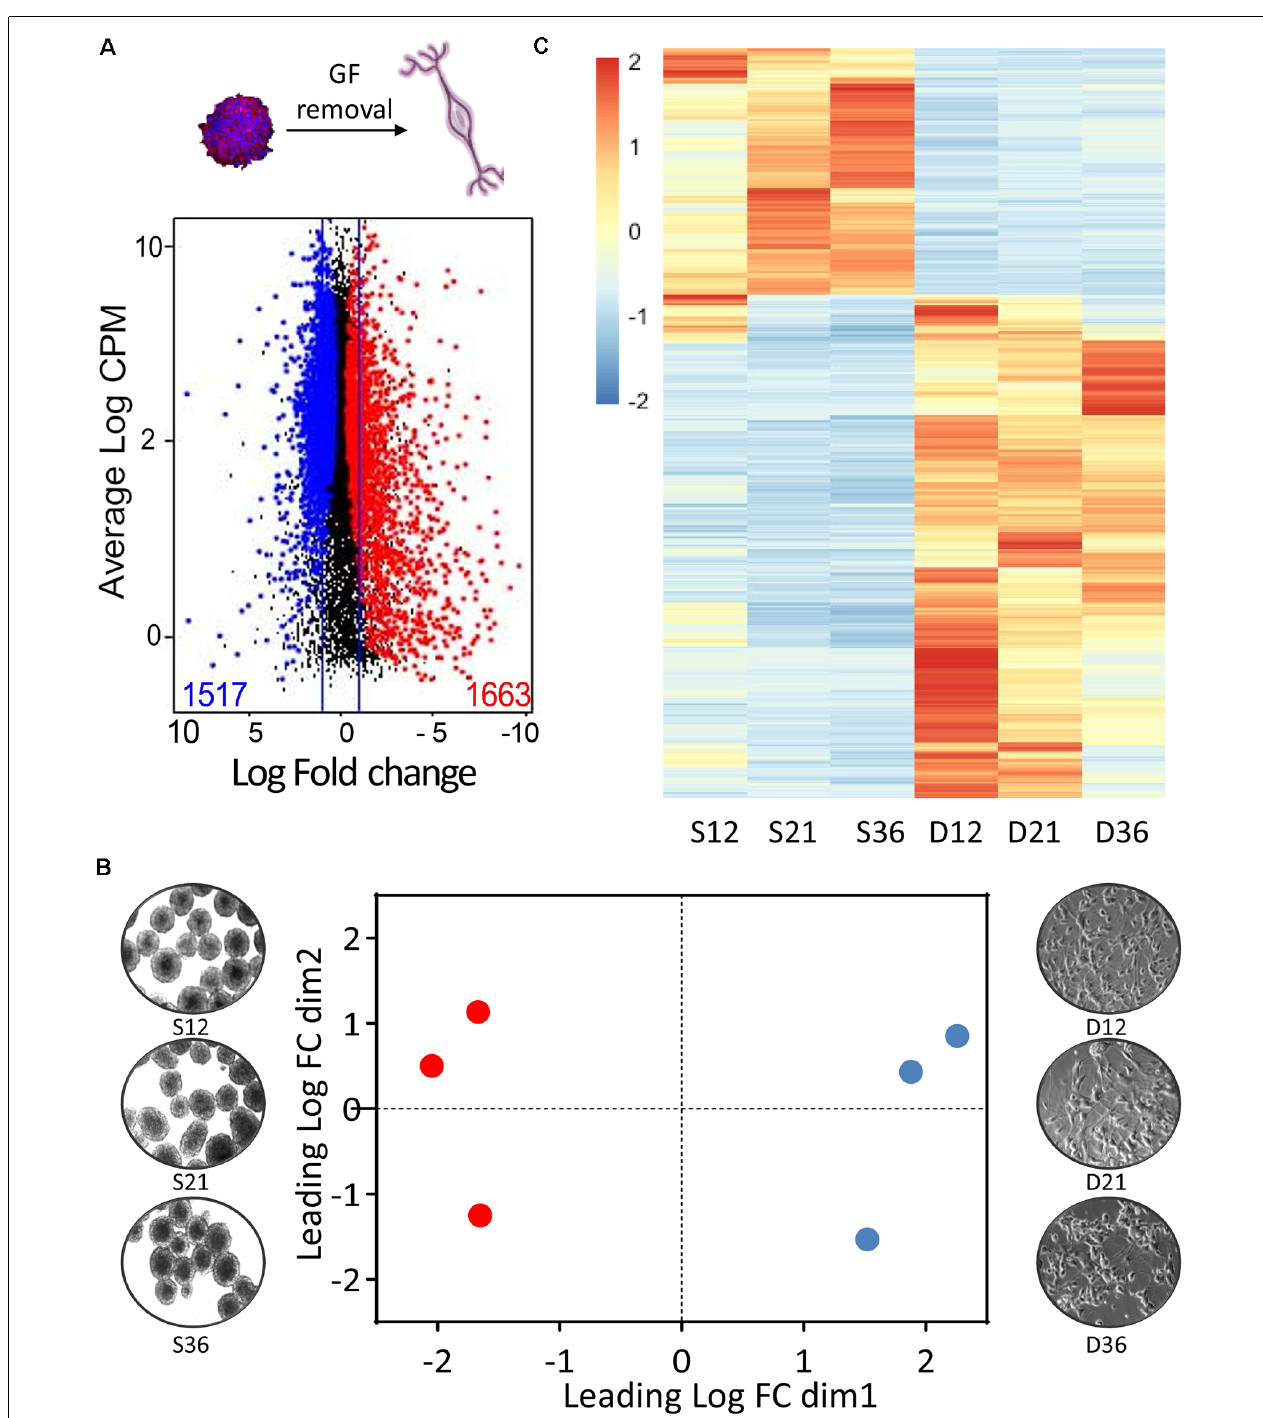
FIGURE 3 | Transcriptomic profile of phoenix auditory neurons. (A) MD plots (mean difference plot of expression data) comparing gene expression in neurospheres and D7 differentiated neurons. Significantly differentially expressed genes at a false discovery rate (FDR) below 5% are highlighted in blue when enriched in neuroprogenitors and in red when enriched in auditory neurons. The lines represent the 2-fold expression change threshold. CPM (counts per million) refers to the number of reads of the gene of interest relatively to the total numbers of reads and is representative of the relative expression of the transcript within the dataset. (B) Multidimensional scanning plot based on the fold changes between all the pairs of samples. (C) Heatmap representing significantly differentially expressed genes between progenitors (S12, S21, S36; column 1–3) and differentiated neurons (D12, D21, and D36; column 4–6). S, spheres; D, differentiated. The number in the sample names corresponds to the passage number of the cells, which are from three independent sources.